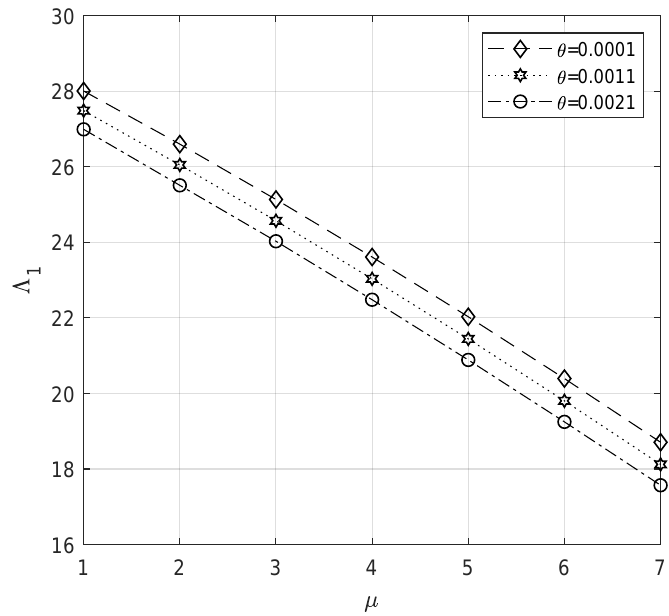
Figure 12. The impact of mean inventory level when θ vs. µ